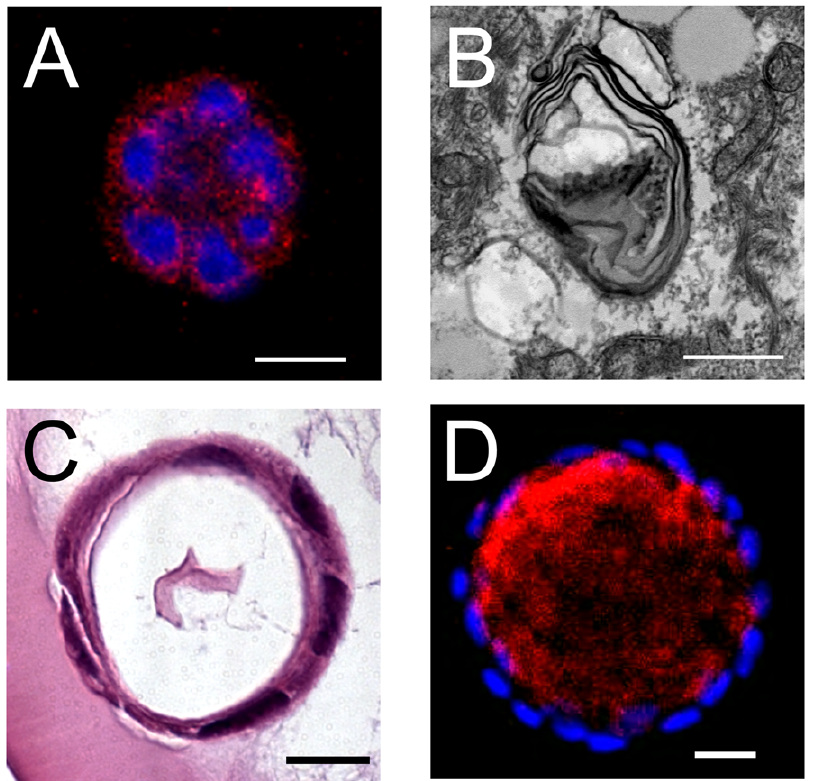
Figure 4. Lamellar Bodies Detected in Subsets of HBEC3 KT Cyst-like Structures after Extended Culture. HBEC3 KT cells were cultured within Matrigel TM for extended periods of time and the potential for differentiation into distal lung cell type monitored. After 7 days in culture, HBEC3 KT cells retain SP-A expression in punctate foci throughout the cytoplasm with subsets of structures containing lamellar bodies. Immunofluorescence staining of SP-A (red) (Fig A; DAPI (blue); scale bar 20 m m) and transmission EM of lamellar bodies (Fig B; scale bar 0.5 m m) in HBEC3 KT cyst-like structures after 7 days of culture. Further culture of HBEC3 KT cells within Matrigel TM results in cyst-like structures comprised of squamous cells surrounding an luminal space in which SP-A is detected. Representative H&E image (Fig C; scale bar 20 m m) and immunofluorescence staining of SP-A (red) (Fig D; DAPI (blue); scale bar 30 m m )in HBEC3 KT cyst-like structures after 9 days of culture. Results are representative of three independent experiments.